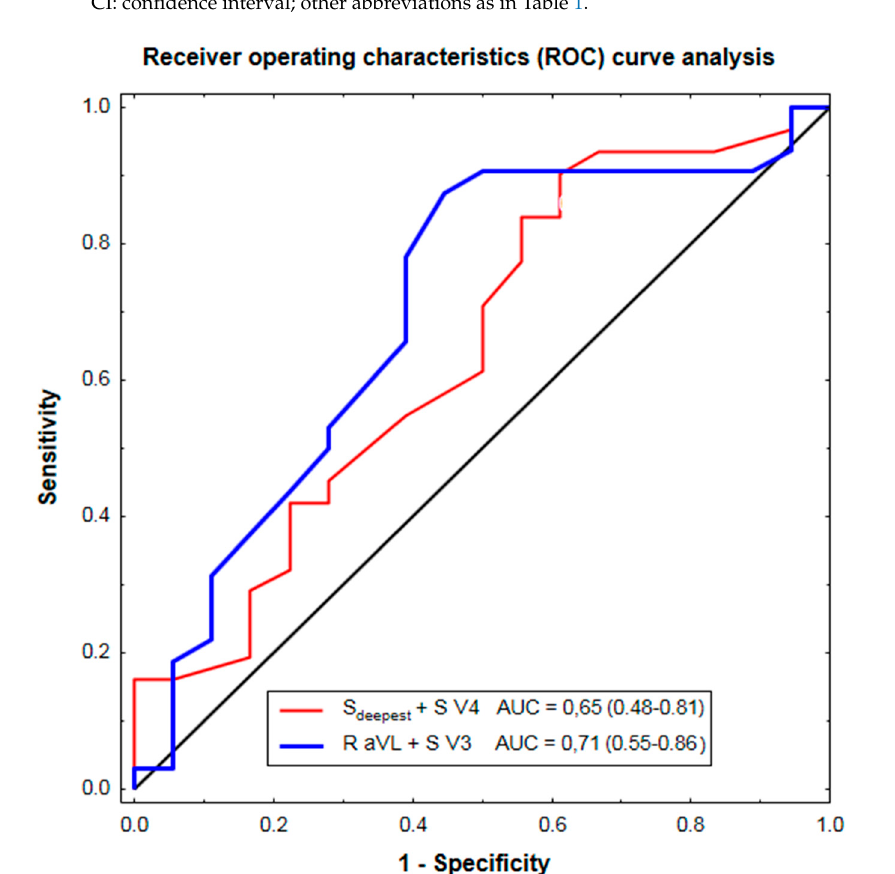
Figure 1. The ability of the Peguero-Lo Presti (S deepest + S V4) and Cornell (R aVL + S V3) voltage as a continuous variable to discriminate aortic stenosis patients with and without echocardiographic LVH, depicted as mean area under the ROC curve (AUC) and 95% confidence interval.